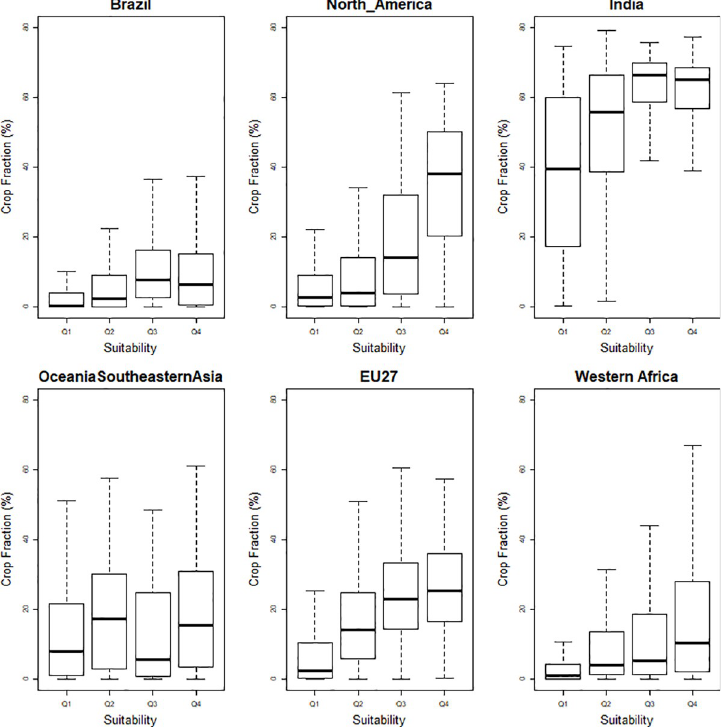
Fig 5. Distribution of crop fractions (%) in areas of 30 arc-minute grid cells for four classes of suitability (Q1, Q2, Q3, Q4) in six regions. The four land suitability classes were defined from the 1 st quartile, median, and 3 rd quartile of the considered suitability